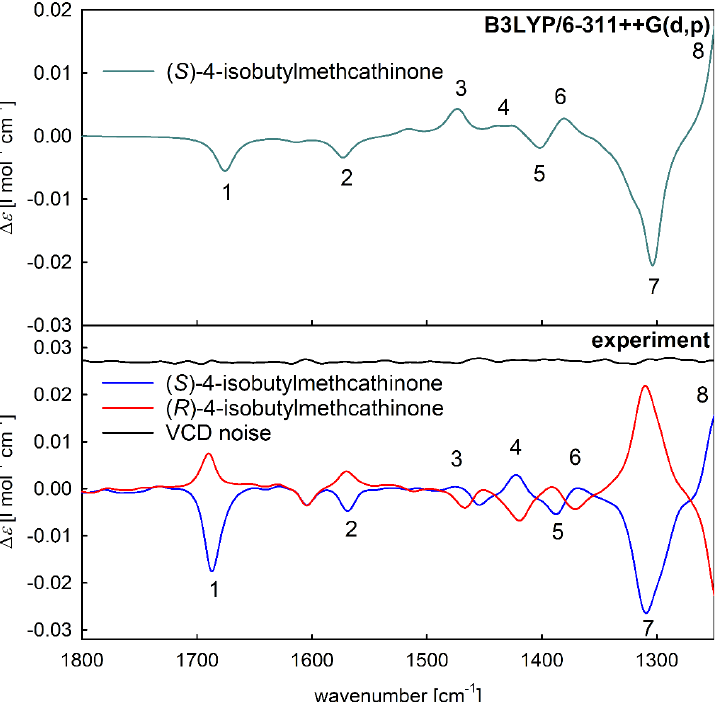
Figure 5. Comparison of the VCD spectra of 4-isobutylcathinone in MeOD- d 4 : the simulated spectrum of ( S )-enantiomer calculated at the B3LYP/6-311++G(d,p) level ( top ) and experimental spectra with the spectrum of noise which was offset for clarity ( bottom ). Similar to VCD analysis, the opposite sign of the experimental ECD spectra (Figure 6, bottom) confirmed the presence of two individual enantiomers. The mutual spectral